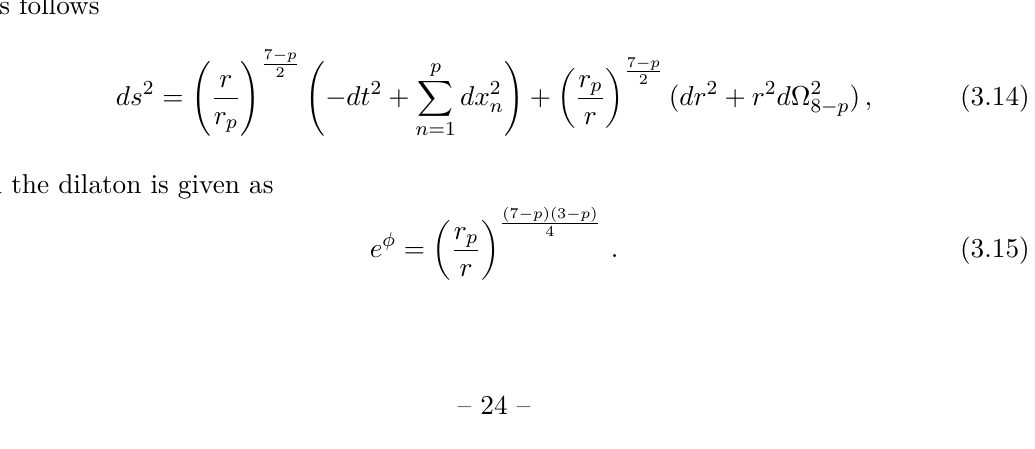
( A : W phase, whereas for B